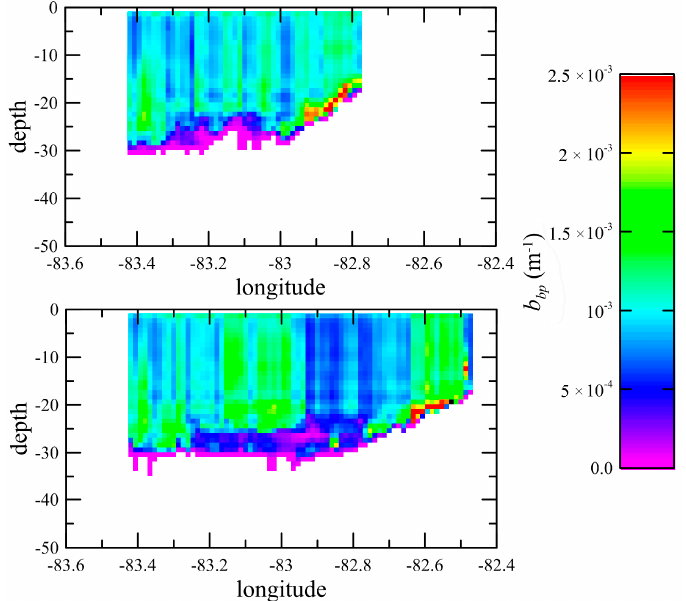
Figure 3. Particulate backscatter coefficient b bp as a function of depth and longitude according to the color table at the right. Top panel is the northern transect and bottom panel is the southern transect. Plot shows the lidar data averaged over the first three flights and binned into 0.01° latitude by 1 m depth bins. Table 1. Table of Pearson correlation coefficients, R , by flight date (2015) and transect using binned data where both lidar and glider values were non-zero. Dash denotes cases where the correlation was not statistically significant. For all other cases, p < 10 − 5 ).